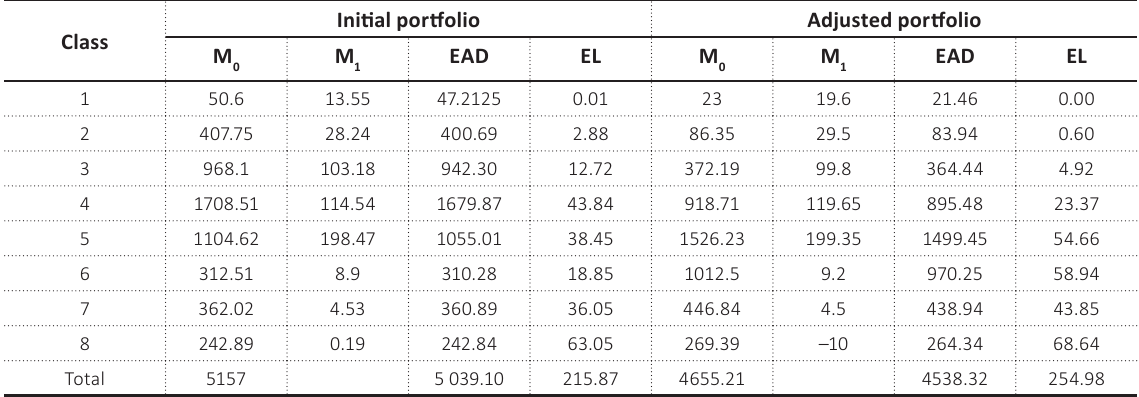
Table 5. LR model – the EL per class (million